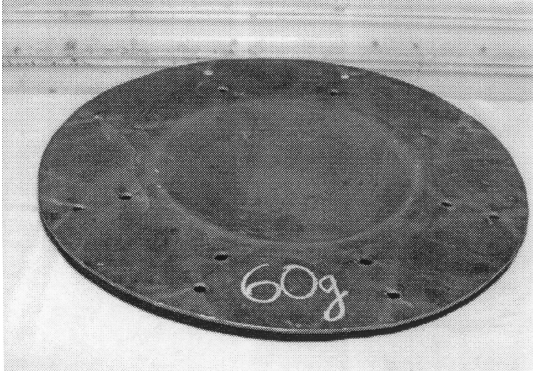
Fig. 10. A photographic view of the plastically deformed plate; explosive charge weight = 60 grams of PEK-1; stand off = 150 mm. Table 5. The thickness reduction varied from 1.25 per